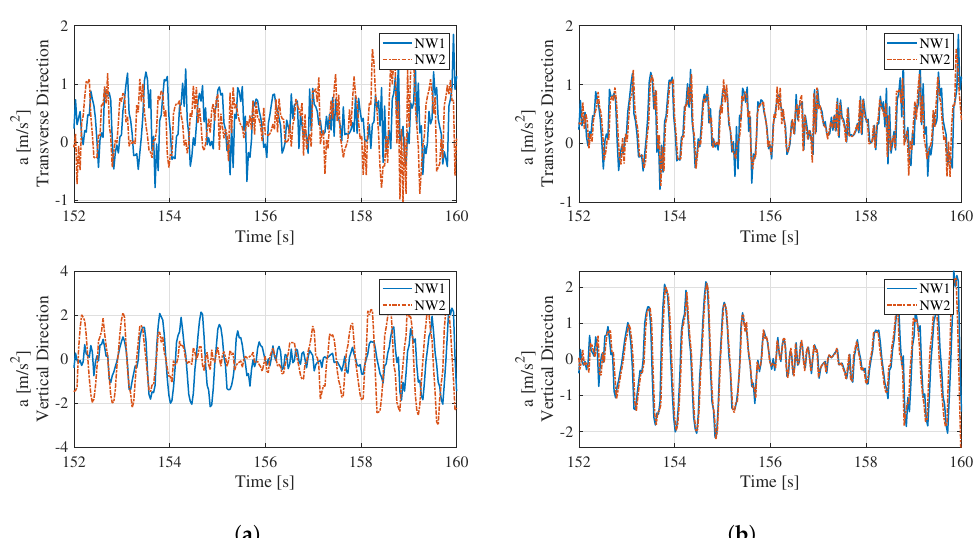
Figure 12. Acceleration data from two the sensors at location 2 (cid:13) : ( a ) pre-synchronization, ( b ) post-